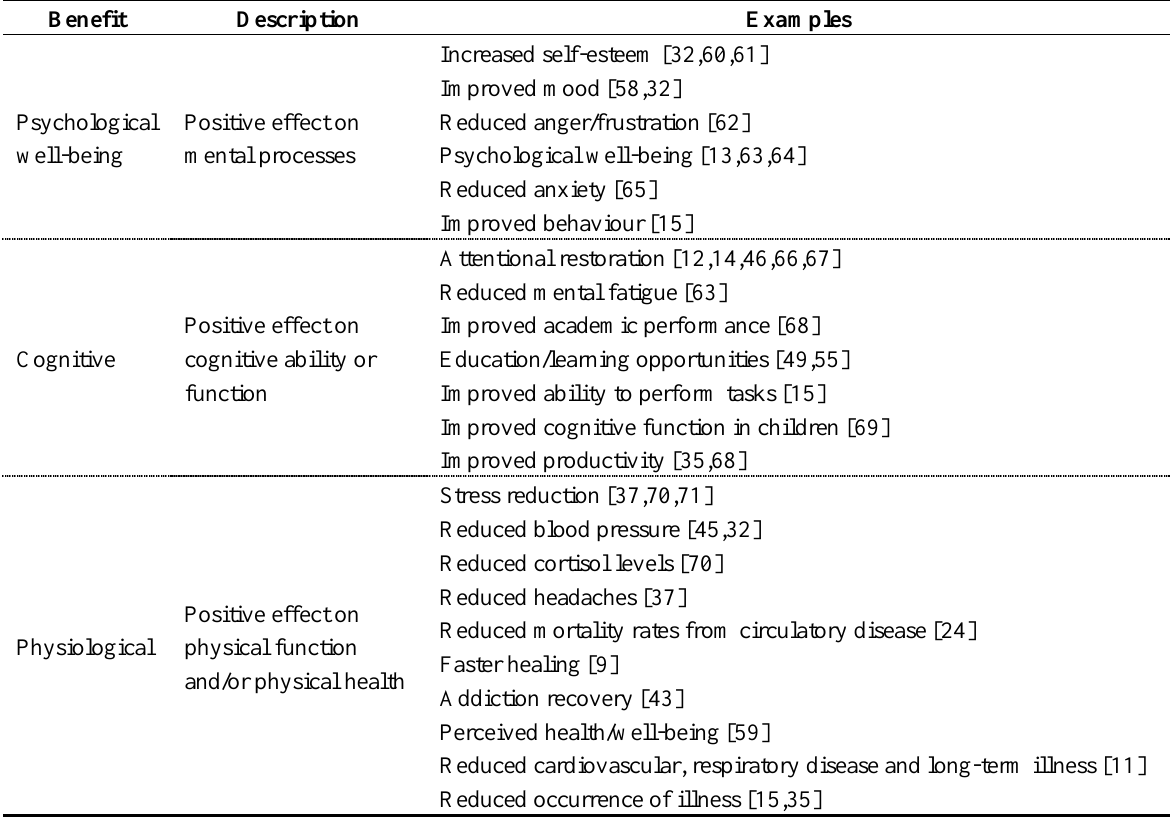
Table 3. Typology of the benefits of interacting with